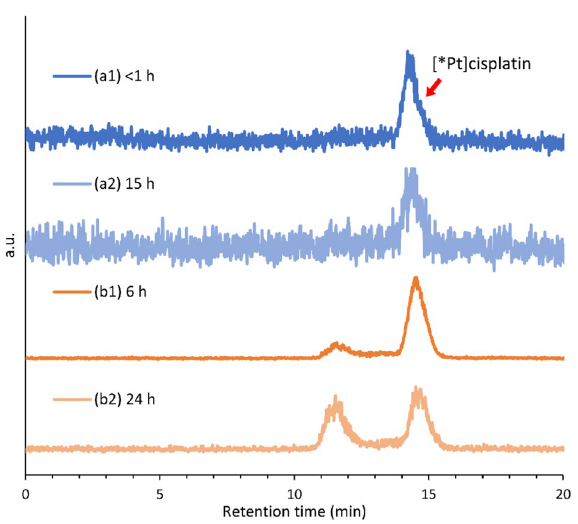
Figure 4. Radiochromatograms of a [*Pt]cisplatin product ( a ) 0.37 ( 189 Pt) + 0.31 ( 191 Pt) + 0.01 ( 188 Pt) MBq/mL at EOS, ( b ) 1.76 ( 189 Pt) + 1.40 ( 191 Pt) + 0.05 ( 188 Pt) MBq/mL at